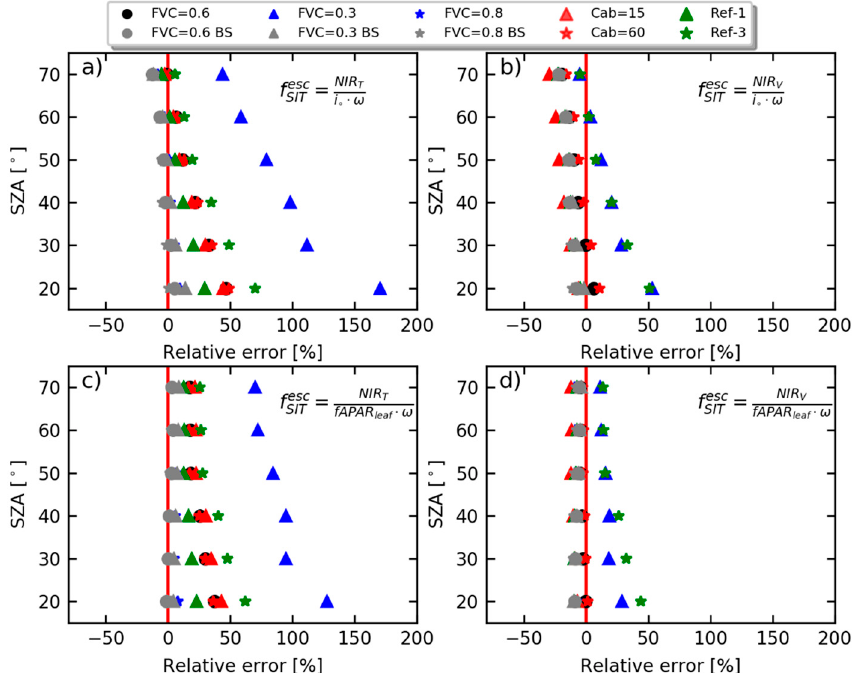
Figure 4. Comparison of SIF escape probability estimated using SIT (i.e., 𝑓 (cid:3020)(cid:3010)(cid:3021)(cid:3032)(cid:3046)(cid:3030) ) with reference values that were simulated by DART (i.e., 𝑓 (cid:3005)(cid:3002)(cid:3019)(cid:3021)(cid:3032)(cid:3046)(cid:3030) ). The calculation formula of 𝑓 (cid:3020)(cid:3010)(cid:3021)(cid:3032)(cid:3046)(cid:3030) was shown in each sub-plot. 𝑓 (cid:3020)(cid:3010)(cid:3021)(cid:3032)(cid:3046)(cid:3030) in the first column ( a , c ) were estimated using NIR T ; while in the second column ( b , d ) using NIR v . 𝑓 (cid:3020)(cid:3010)(cid:3021)(cid:3032)(cid:3046)(cid:3030) in the first row ( a , b ) were estimated using i o ; while in the second row ( c , d ) using fraction of absorbed photosynthetically active radiation (fAPAR). BS means black soil (i.e., non-reflecting